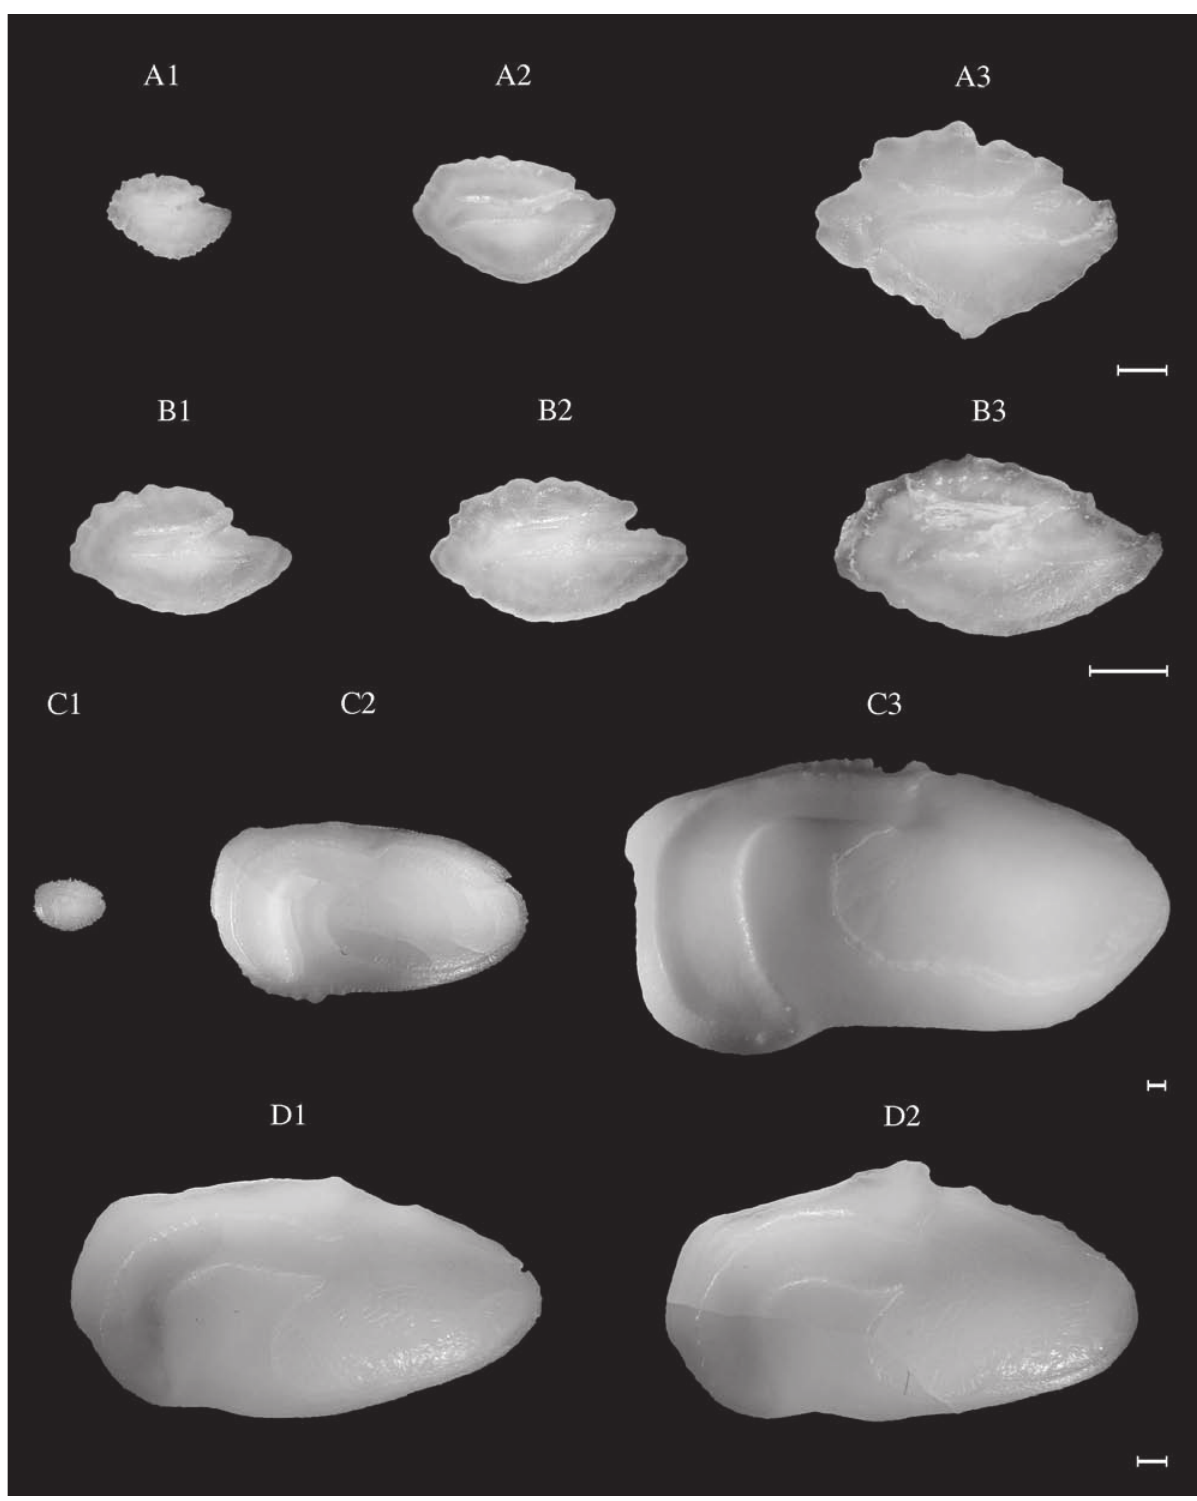
Fig. 63. – Spicara maena (WM). TL: A1, 7.7 cm; A2, 12.0 cm; A3, 19.5 cm. Spicara smaris (WM) . TL: B1, 9.0 cm; B2, 11.0 cm; B3, 13.5 cm. Argyrosomus regius . TL: C1, 9.5 cm (NEA); C2, 60.8 cm (NEA); C3, 123.3 cm (CEA). Atractoscion aequidens (CEA). TL: D1, 48.0 cm; D2, 55.0 cm. Scale bar = 1